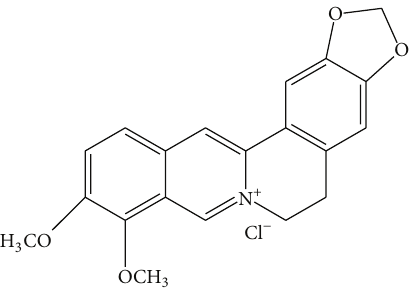
Figure 1: Chemical structure of